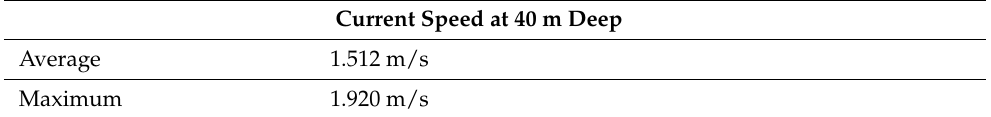
Table 2. Current speed.